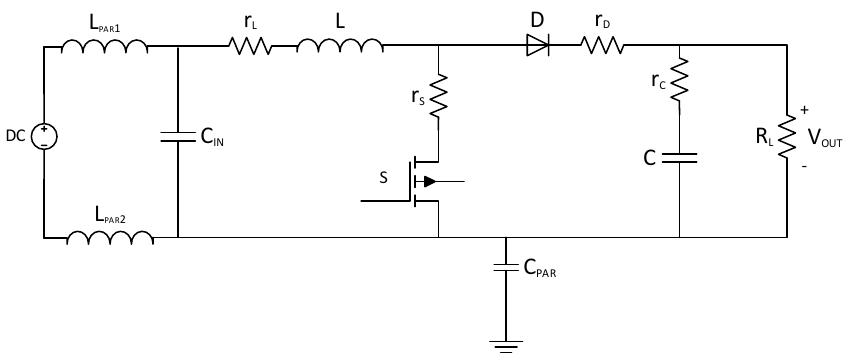
Figure 2. Model of the Boost converter, including non-ideal components.